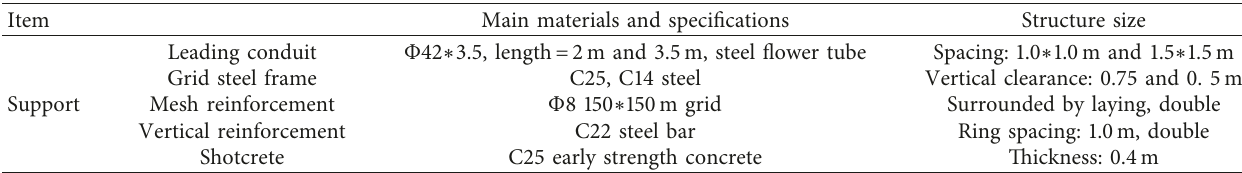
Figure 2: Profile of soil layers, tunnel from Yue Deng Pavilion Station to San Dian Village Station (units: m; vertical scale:1:100; horizontal scale: 1:1,000). Table 1: Shaft support parameters.